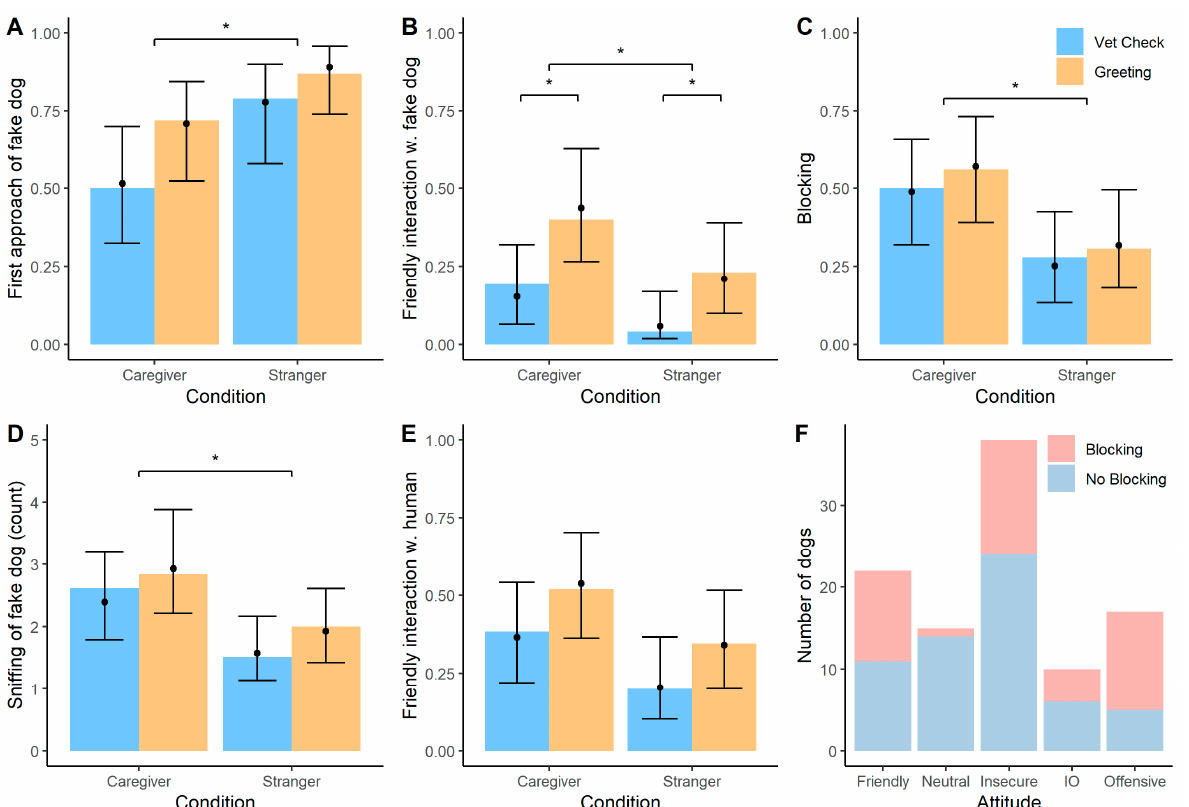
Figure 5. Bar plots showing different response variables in the reaction phase across the treatment and human conditions and the behavioural ratings. ( A ). Proportion of dogs that showed blocking behaviour. ( B ). Mean count of sniffing instances of the anal region of the fake dog. ( C ). Proportion of dogs that interacted in a friendly manner with the fake dog. ( D ). Proportion of dogs that first approached the fake dog (and not the human demonstrator). ( E ). Proportion of dogs that interacted with the human demonstrator in a friendly manner. ( F ). Number of dogs according to their attitude ratings in the reaction phase and divided into dogs that showed a blocking behaviour or not. The error bars represent 95% confidence intervals, the black dots show the model predictions, * GLM, p <